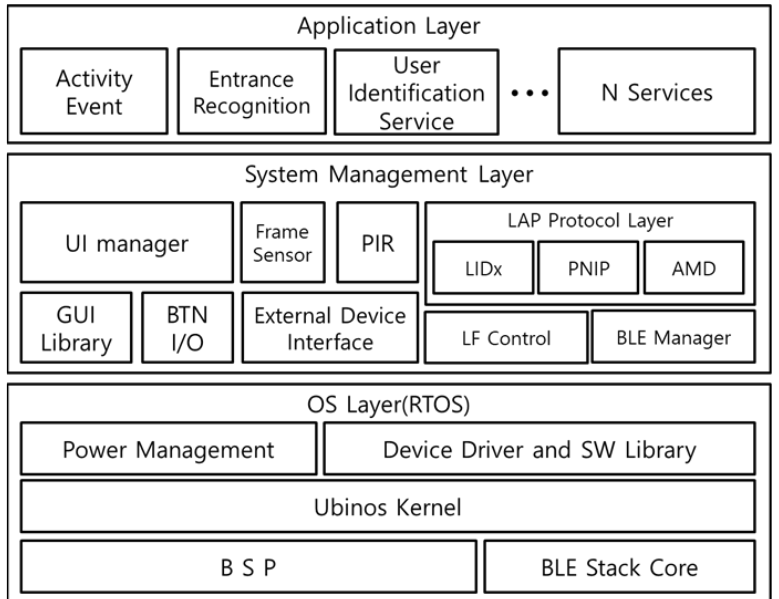
Figure 4. Software Architecture of Stationary Resource Device.